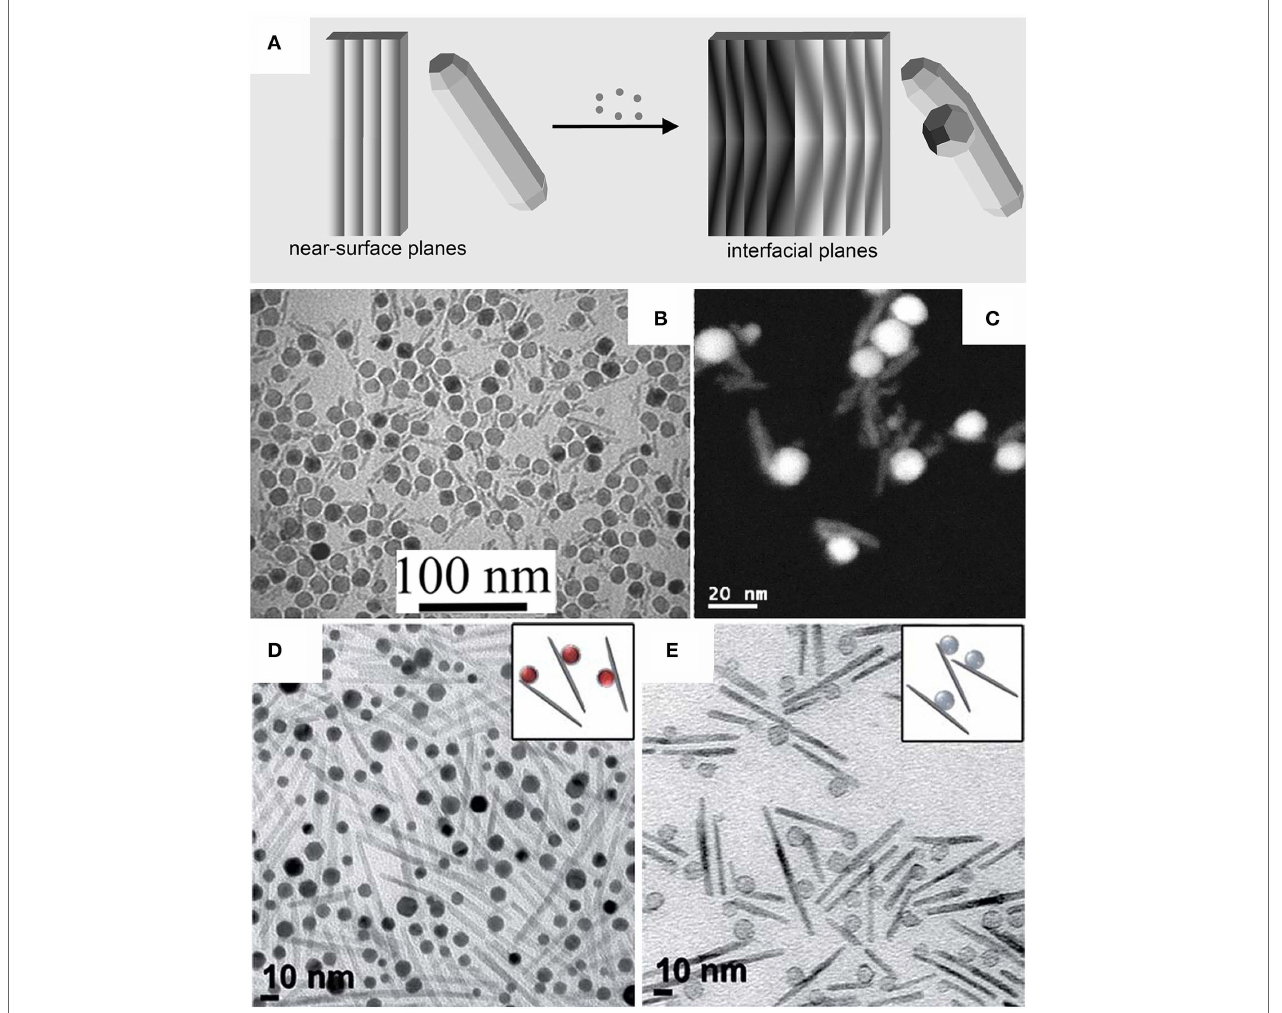
FIGURE 9 | Examples of magnetic heterostructured nanocrystals formed upon strain-driven heteroepitaxial growth . (A) Sketch of the mechanism [adapted from Casavola et al. (2008) with permission, copyright Wiley-VCH Verlag GmbH & Co. KGaA]. (B,C) Low-resolution transmission electron microscopy (TEM) image and high-angle annular dark-field image in scanning transmission electron microscopy mode, respectively, of binary heterostructures made of single- γ -Fe 2 O 3 -functionalzied anatase TiO 2 nanorods [reproduced with permission from Buonsanti et al. (2006), copyright American Chemical Society]; (D) TEM images of binary heterostructures made of asymmetrically Au@Fe x O y -decorated Fe x O y nanorods; and (E) corresponding all-Fe x O y nanostructures obtained after Au leaching [reproduced from George et al. (2011b) with permission from The Royal Society of